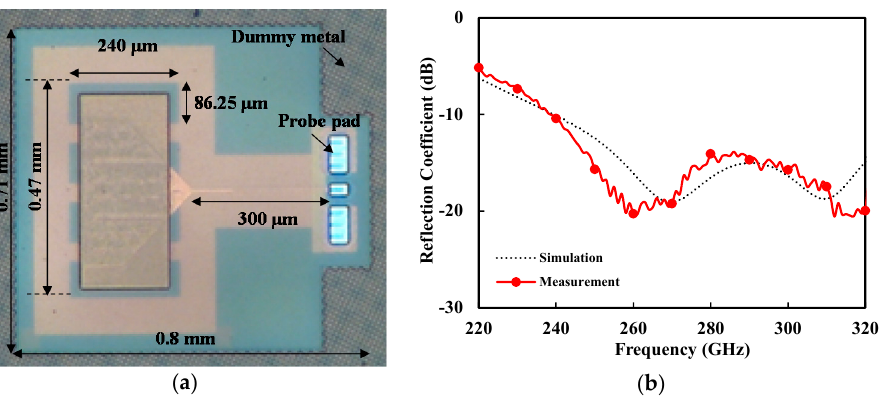
Figure 10. ( a ) Photograph of the fabricated on-chip antenna. ( b ) Measured input reflection coefficient of the proposed antenna.